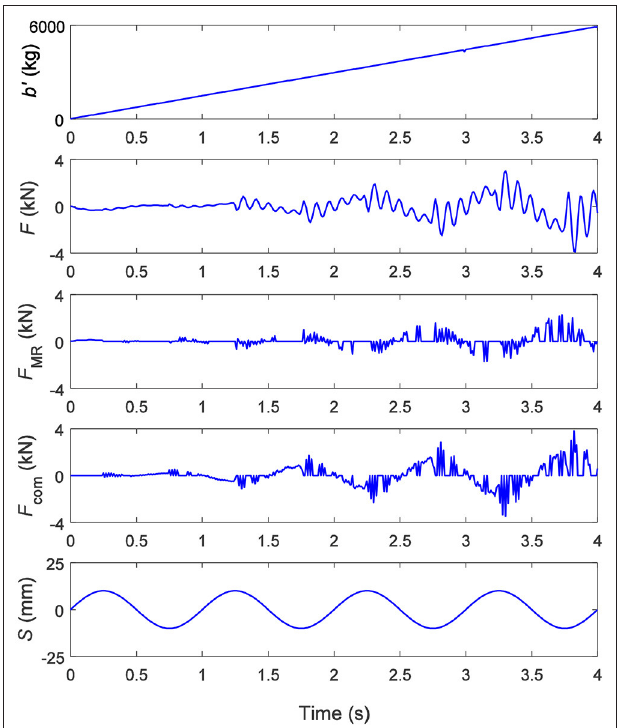
FIGURE 12 | The equivalent inertance b ′ , the output force F , the controllable force F MR and the generated force of the compensator F com under a sinusoidal displacement excitation S with an amplitude of 20mm and a frequency of 1.0Hz when the expected inertance of the SAI with a compensator is from 0kg to 6,000kg.